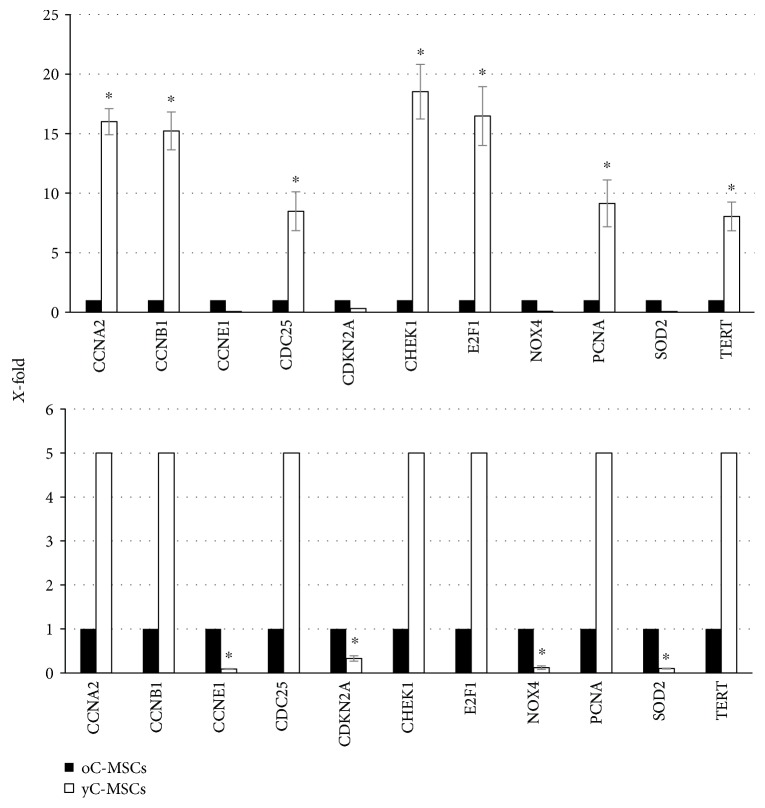
Expression of genes related to senescence. The expression of 86 genes referred to senescence was evaluated by a PCR array. Choosing a 3-fold cut-off, expression of CCNA2, CCNB1, CDC25, CHEK1, E2F1, TERT, and PCNA was upregulated in yC-MSCs compared to oC-MSCs, while that of CDKN2A, CCNE1, NOX4, and SOD2 was downregulated. Data are means ± SD from analyses performed on three separate experiments. ∗p < 0.05 for yC-MSCs versus oC-MSCs.